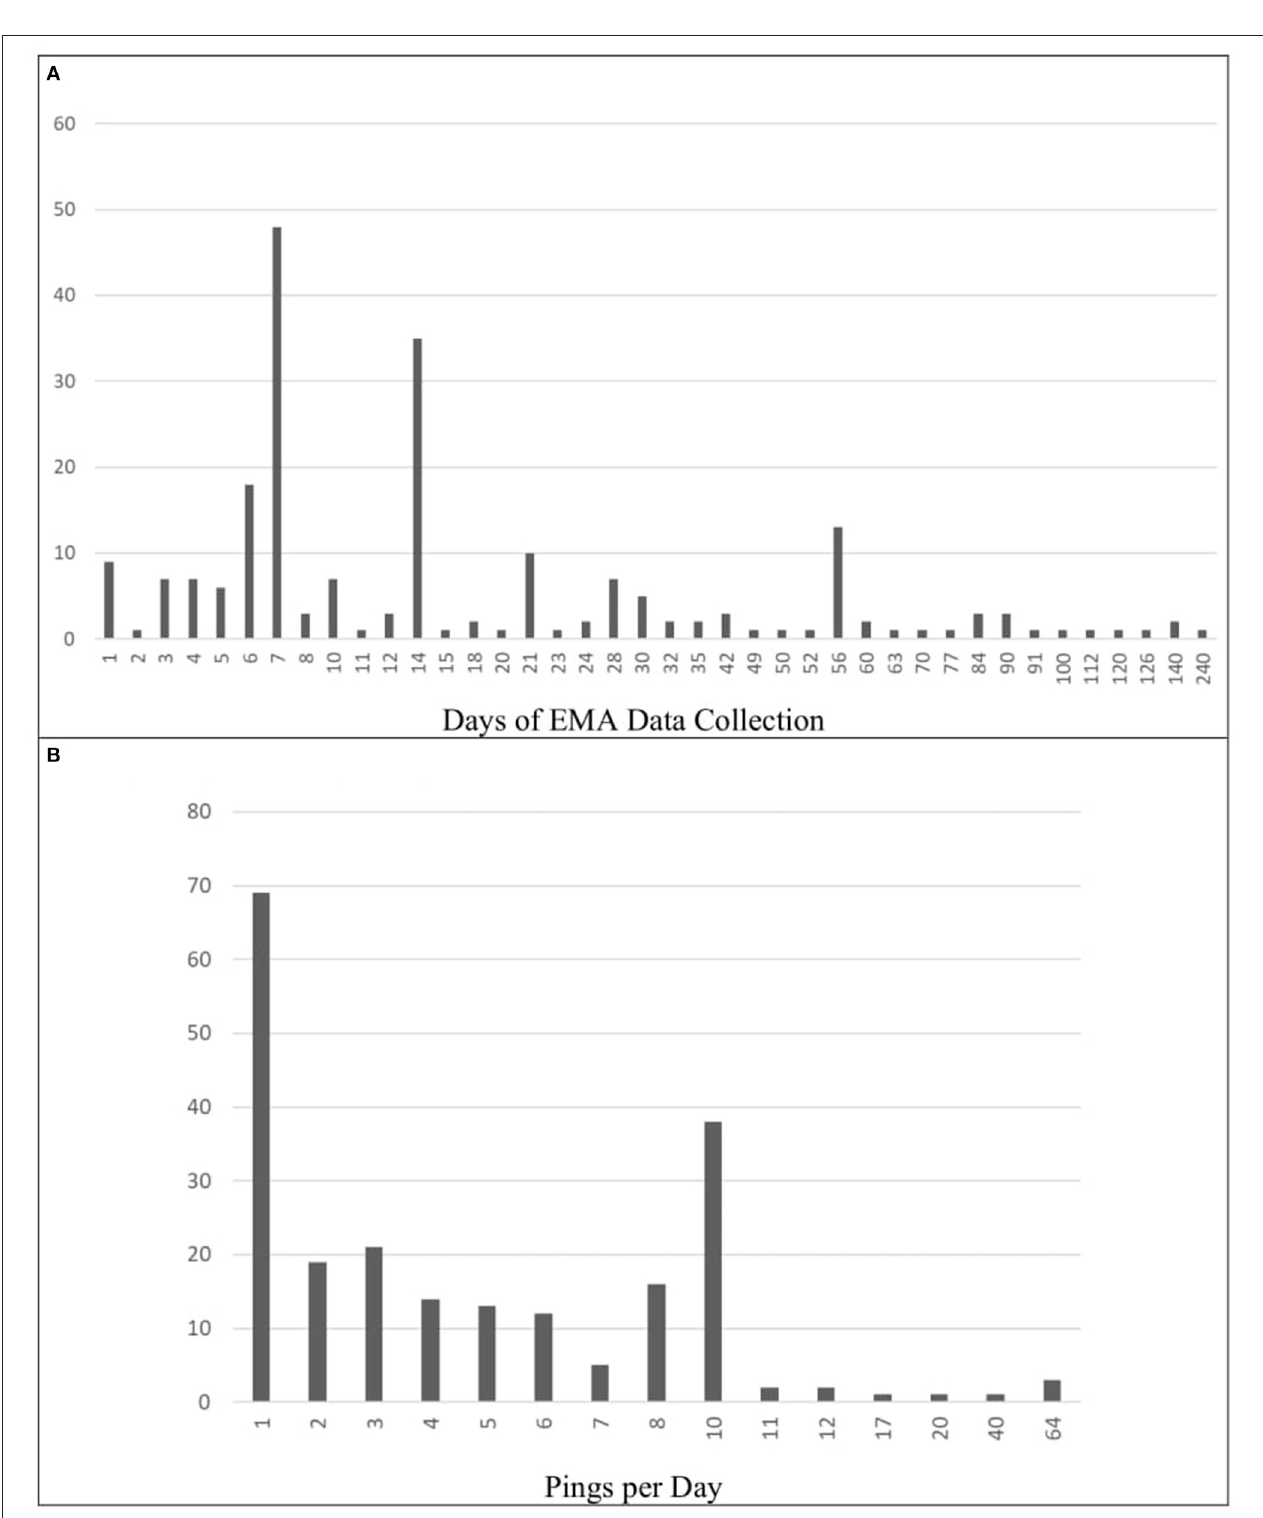
FIGURE 2 | Frequencies of data collection schedules (Total days and Pings per day). (A) Frequency of Total EMA Data Collection (in Days). (B) Frequency of Pings per Day. Panel A shows the how many days of EMA data collection were used throughout the selected papers. In some papers, this information was either missing or unclear ( N = 18). Panel B displays how many times per day participants were pinged across these same papers. All papers included in the review reported pings per day.